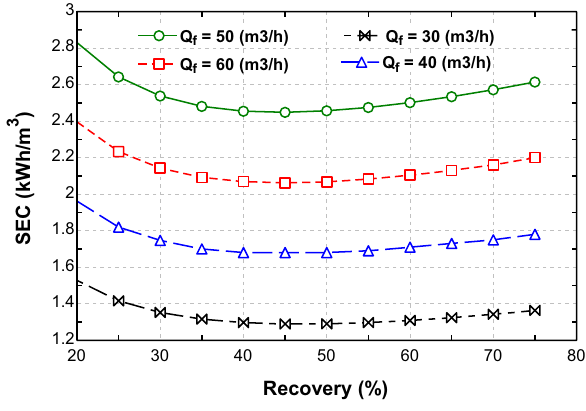
Fig. 5 Sensitivity analysis of produced fresh water flow rate on mem- brane change in different concentrations of inlet water on the mem- brane